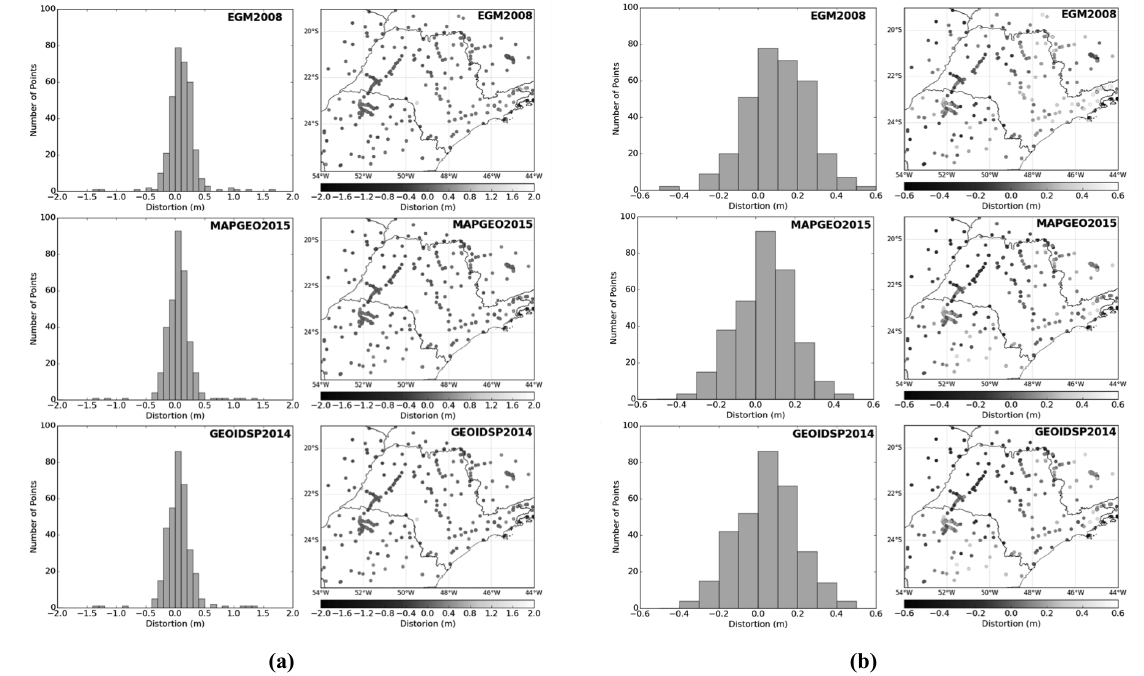
Figure 5 - Distortions (in meters) of geoid models EGM2008, MAPGEO2015 and GEOIDSP2014 regarding benchmarks tracked by GNSS ( a ) before and ( b ) after filtering data (see the colors in the online